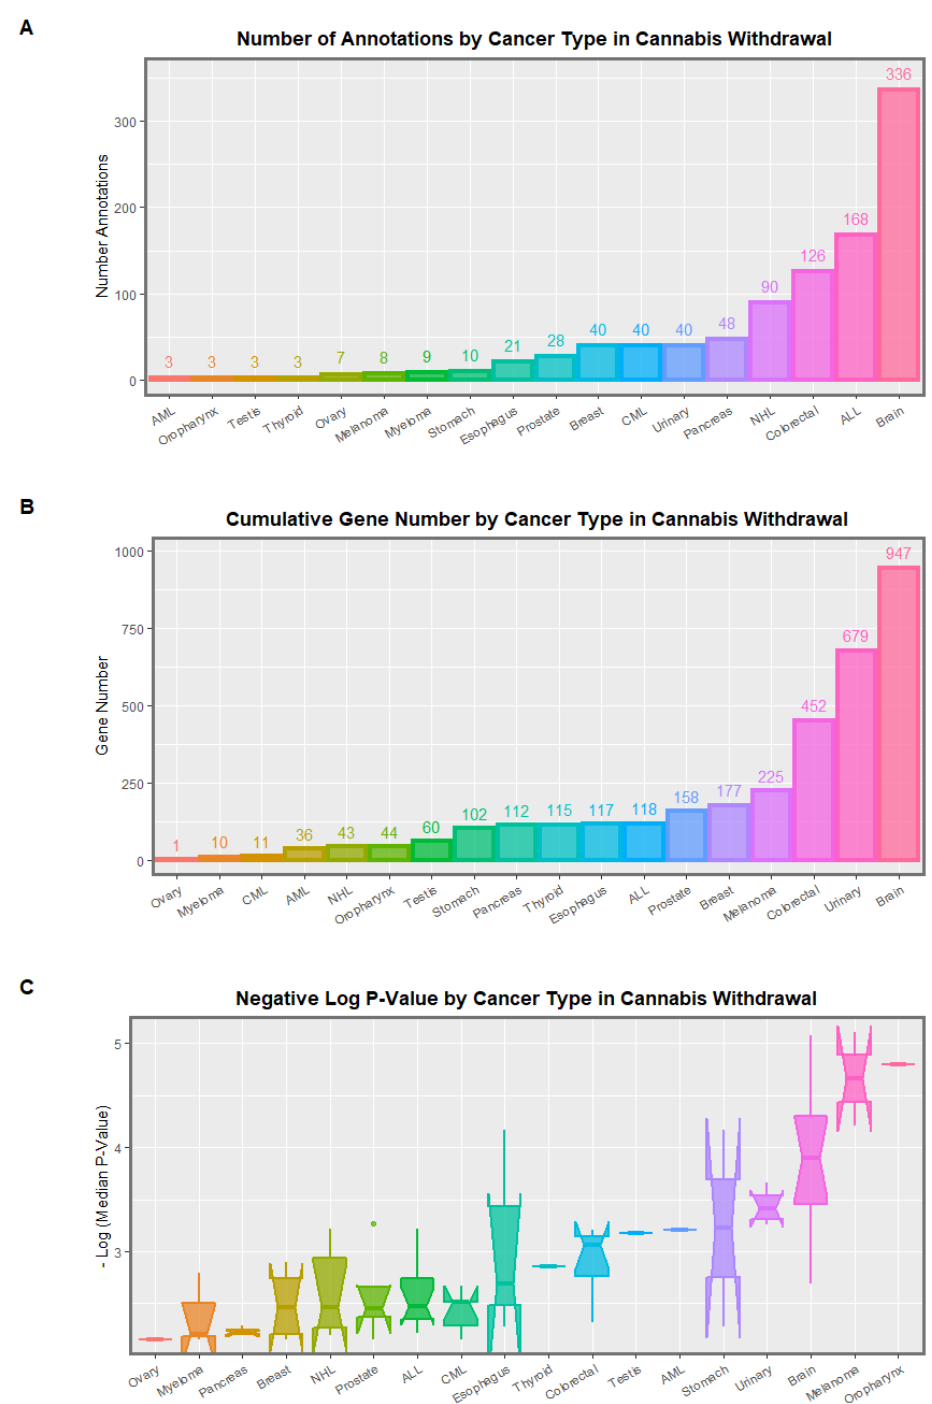
Figure 4. ( A ) Numbers of gene annotations, ( B ) numbers of genes affected and ( C ) negative loga- of p -value by cancer type—cannabis withdrawal Schrott rithm of p -value by cancer type — cannabis withdrawal Schrott data.